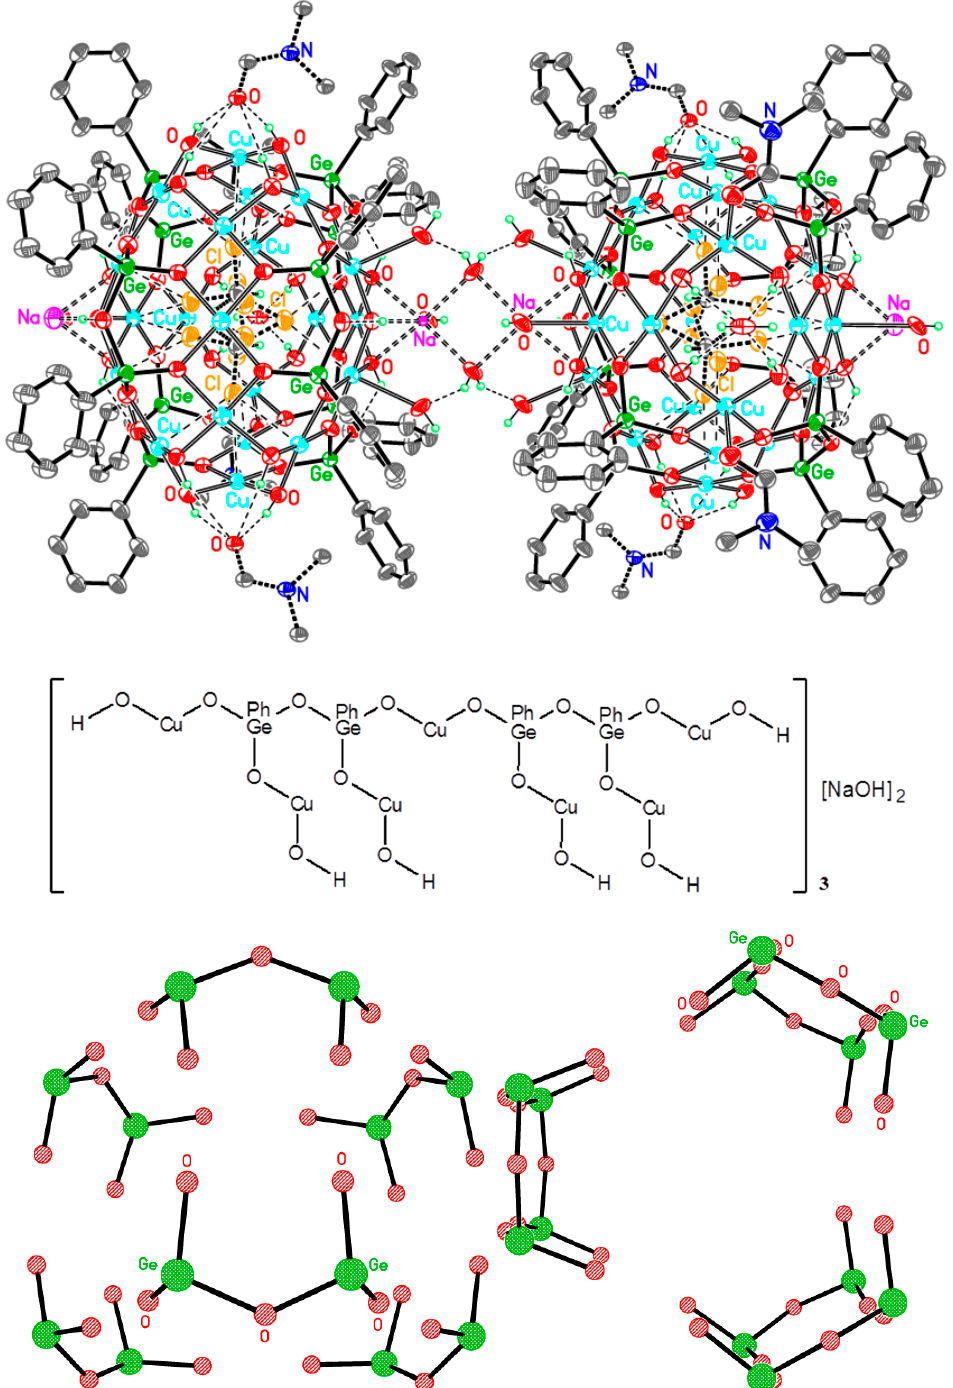
Figure 2. Top panel. The molecular structure of 1 . Central panel. A sketch of the cage’s building block in 1 . Bottom panel. The structure of acyclic germoxane ligands in 1 .